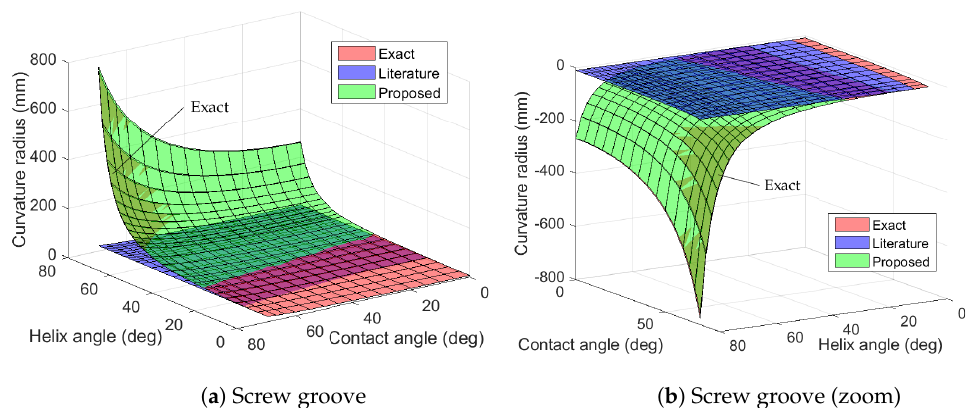
Figure 8. Comparison between the first principal curvature radius exact values with the results of the proposed simplified formula and the literature formula for the ( a ) screw shaft and ( b ) nut grooves, for a ball screw with r m = 8 mm, r b = 1.5875 mm, H = 0.0629 mm and L = 0.0505